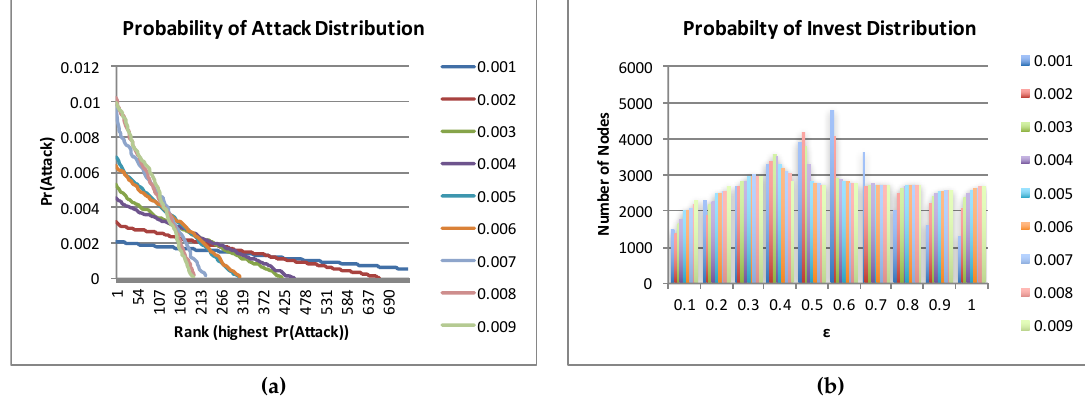
Figure 6. Attacker’s and Site’s (cid:101) -mixed-strategy Nash equilibria (MSNE) Strategies for a Randomly-Generated Internet Game. The graphs show the empirical distributions of the probability of attack ( a ) and histograms of the probability of investment ( b ), for different (cid:101) -value conditions encoded in the right-hand side of the plots (i.e., from 0.001 to 0.009). In both graphs, the distributions and histograms found for each (cid:101) value considered are drawn in the same corresponding graph superimposed. The left-hand graph plots the distribution of y i where the nodes are ordered decreasingly based on the y i value. The right-hand bar graph shows histograms of the probability of investing in defense/security measures based on the following sequence of 10 ranges partitioning the unit interval: ([ 0,0.1 ] , ( 0.1,0.2 ] ,..., ( 0.9,1 ])